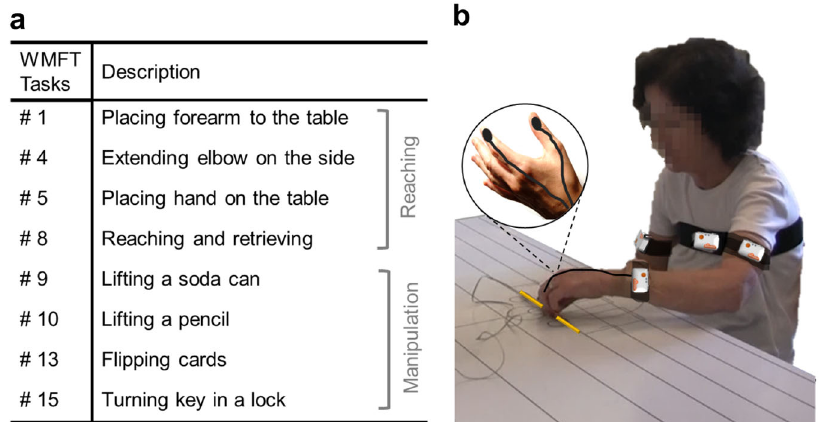
Fig. 5 Experimental procedures. Functional tasks performed during the data collections a and position of the wearable sensors b